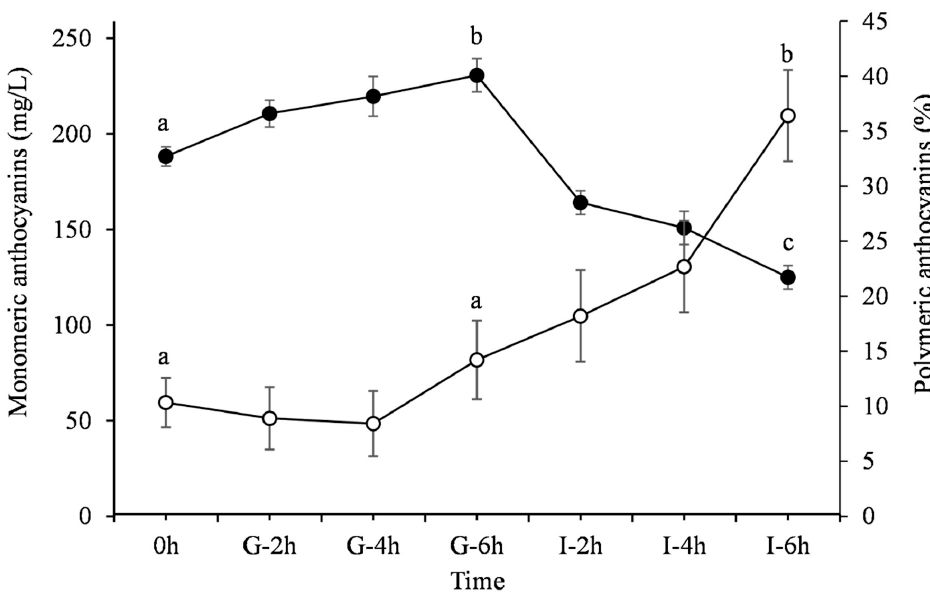
Figure 1. The evolution of the total monomeric anthocyanins (ACNs) content (- ● -) and percent polymeric color (- ○ -) of PJ under simulated digestion process (SDP) (0 h; G-2 h, G-4 h, G-6 h: samples under the gastric condition; I-2h, I-4h, I-6h: samples under the intestinal condition). Different letters denote statistical significance ( p < 0.05) between time points of each curve.